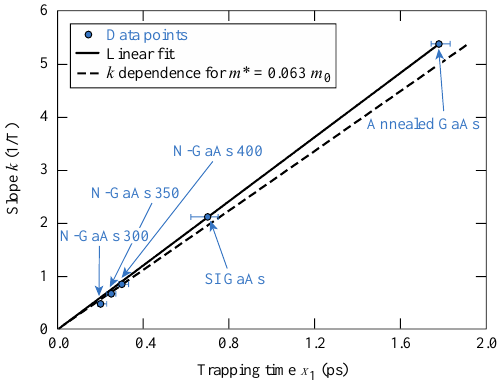
Figure 8. Dependence of the slope k dependence on the trapping time 𝜏 1 . The dots are experimental data points, and a black line is the best linear fit yielding 𝑚 ∗ 𝑚 0 ⁄ = 0.059 . The dashed line corresponds to the k dependence for 𝑚 ∗ 𝑚 0 ⁄ = 0.063 , the literature value for GaAs [34].